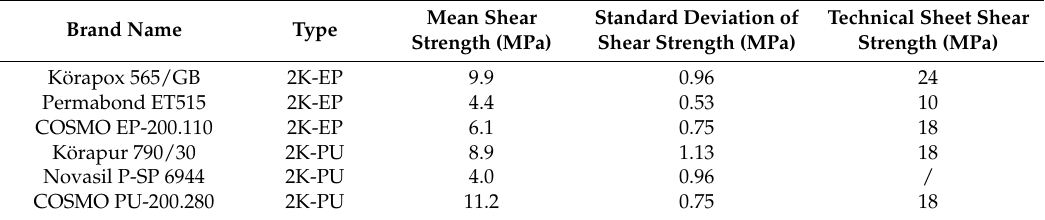
Table 2. Adhesives characteristics and experimental results of their shear strength.